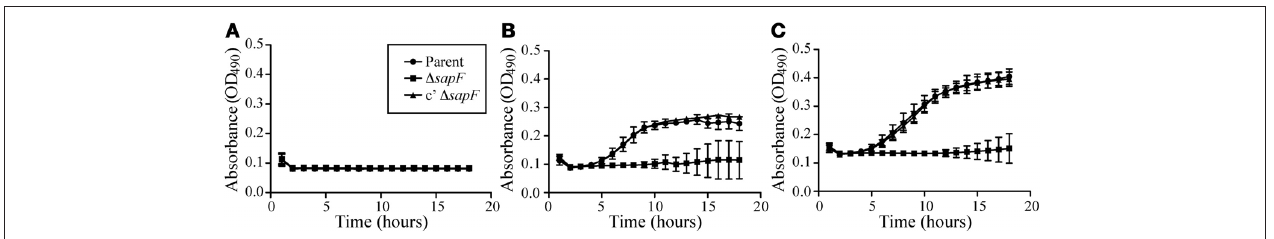
FIGURE 3 | Role of SapF ATPase in heme utilization. The parent strain (circle), the SapF-deficient strain (square), and the complemented SapF-deficient strain (triangle) were iron-starved for 16h in DIS medium in the absence of heme, matched for CFU, and subcultured in DIS medium